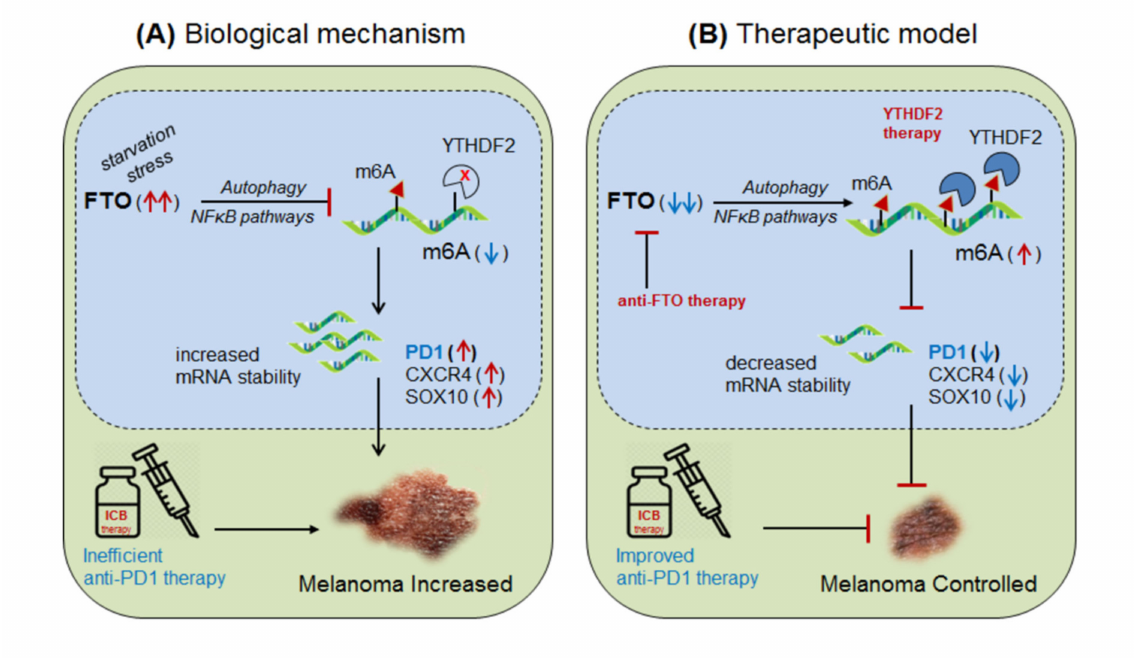
Figure 5. Therapeutic model targeting ‘FTO’ in melanoma. ( A ) Biological mechanism: FTO is highly up-regulated in melanoma (due to starvation stress through NF κ B-pathways and autophagy) leading to increased mRNA transcript of the critical pro-tumorigenic genes (PD-1, CXCR4 and SOX10) by decreasing m6A-methylation mark, resulting in increased melanoma progression. ( B ) Therapeutic model: (i) Anti-FTO therapy: selective inhibition of FTO (FTO inhibitor [125]) or intracellular silencing of ‘FTO’ controls melanoma progression by selectively increasing the methylation-inhibition of its pro-tumorigenic genes, including PD-1 immune checkpoint markers by increasing the efficacy of anti-PD-1 antibody [163]. (ii) YTHDF2 therapy: YTHDF2 overexpression would control melanoma progression by accelerating the mRNA-decay of critical pro-tumorigenic genes. Moreover, targeted overexpression of Mettl-3 might control melanoma progression by destabilizing critical tumor-promoting genes by recruiting YTHDF2-reader proteins. Furthermore, targeting NF κ B/mTOR signaling might also control melanoma progression by limiting nutrient supply to the